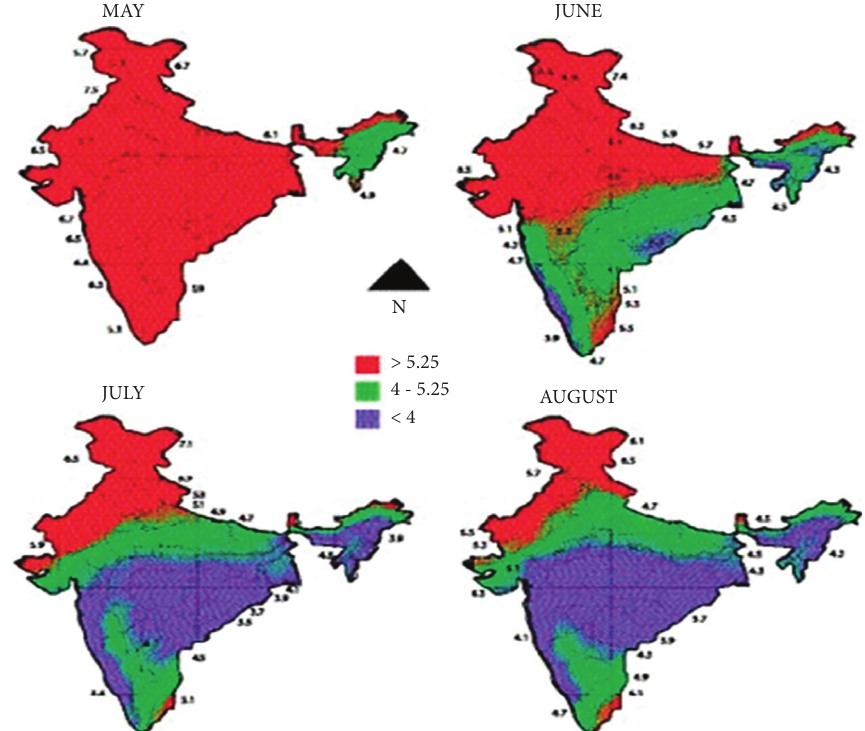
Figure 2: Month-wise intensity of solar radiation [2].